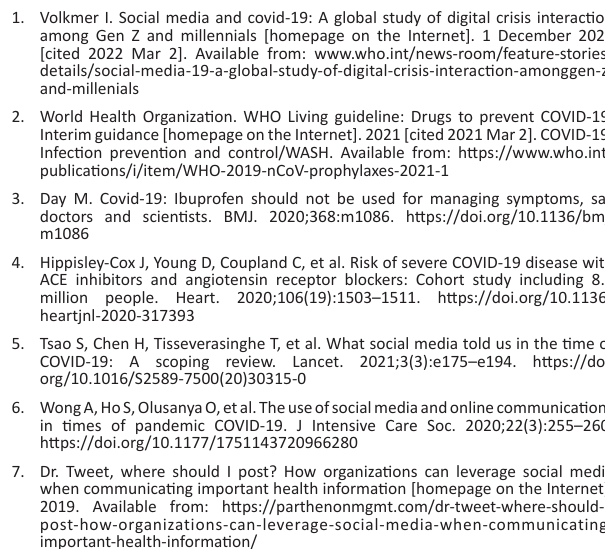
FIGURE 1: Doctors interact with social